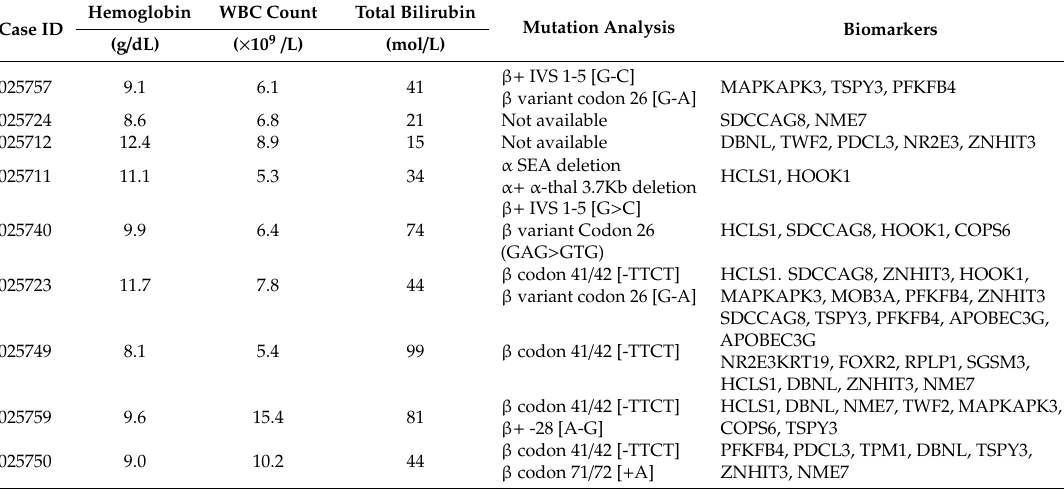
Table 1. Clinical data of beta-thalassemia major patients and summary of their autoantibody biomarkers profile.